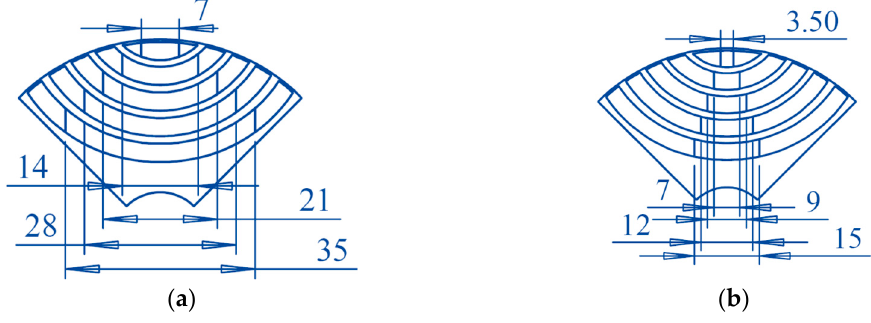
Figure 2. Geometrical dimensions of PMA-SynRG, ( a ) ferrite (G1), ( b ) NdFeB (G2).